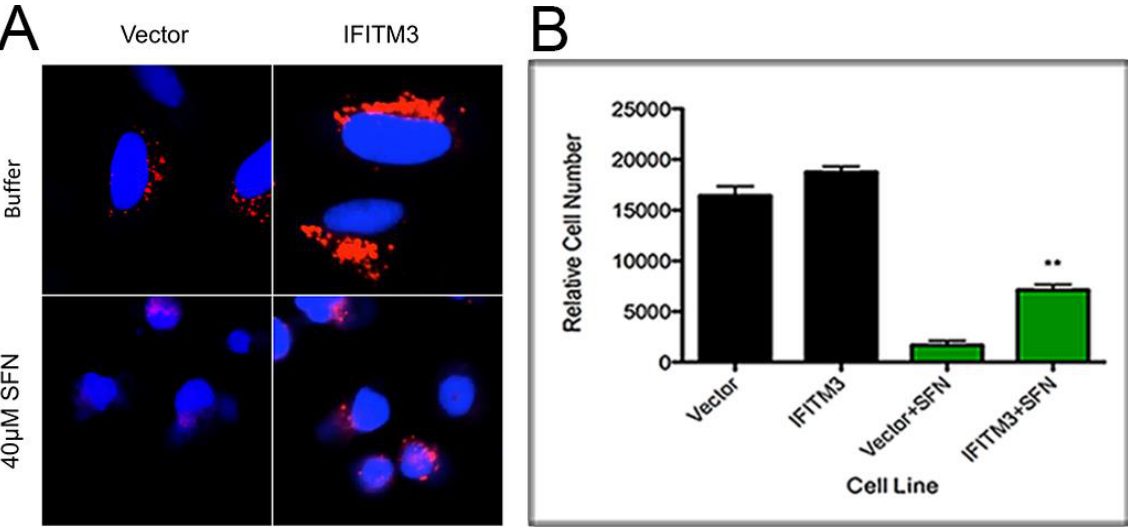
FIGURE 3: SFN increases the pH of endosomes of human A549 cells. (A) Cells from the A549 human alveolar adenocarcinoma cell line with and without overexpressed IFITM3 were cultured in media with and without 40 μM SFN and the pH -sensitive dye, Lysotracker Red. Interfer- on-inducible Transmembrane Protein 3 (IFITM3) is known to enlarge the late endosomes and lysosomal compartments as well as to increase their acidity. A549 cells grown with SFN were less positive for the dye than cells grown in the absence of the drug suggesting that they have more alkaline endosomes. (B) The viability of A549 cells with or without IFITM3 cultured in media with or without SFN was determined by Hoechst staining. Error bars indicate standard deviations for trials with at least three independent cultures. The difference in viabilities was deemed statistically significant by the Student’s t -test comparing cells grown in drug with control cells grown in the absence of drug (**